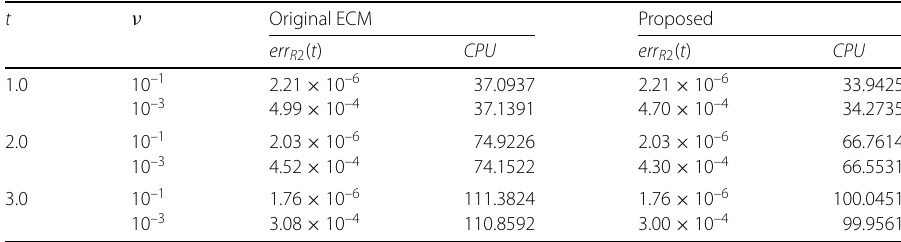
Table 6 Comparison of errors and CPUs of v via the proposed method and the original ECM for Example